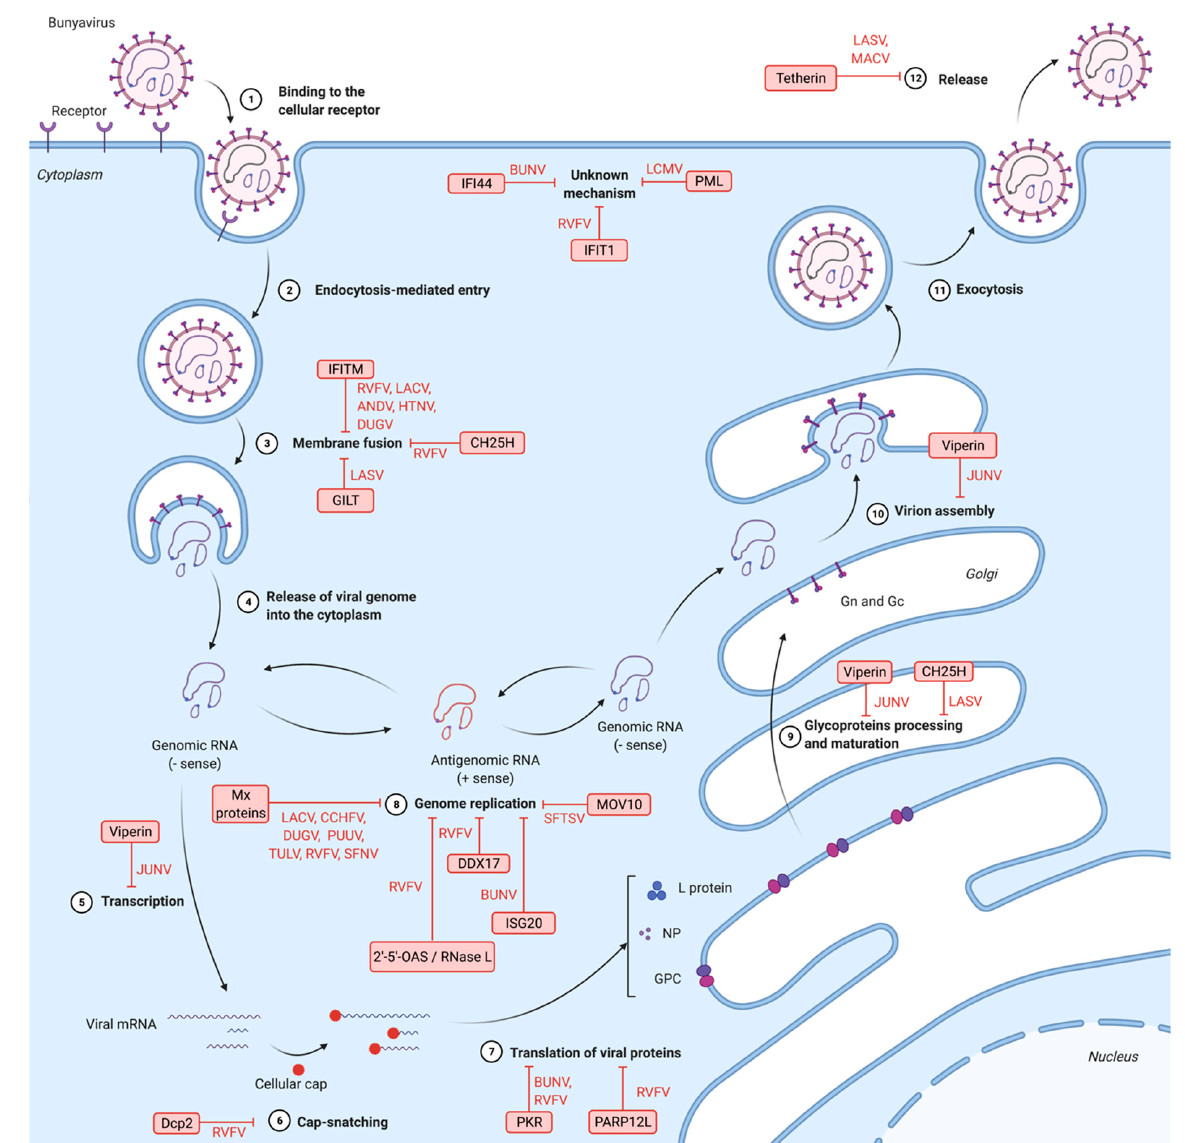
Figure 2. Steps of the bunyavirus cycle inhibited by host restriction factors. Bunyaviruses bind to the receptor (1), then enter the cell and release their genome into the cytoplasm (2, 3 and 4). Genomic RNA is then transcribed into mRNA (5 and 6), later translated into viral proteins (7 and 9). Moreover, genomic RNA is replicated (8). New virions assemble and exit the cell (10, 11 and 12). Each step of the cycle can be inhibited by host restriction factors, which are written in red